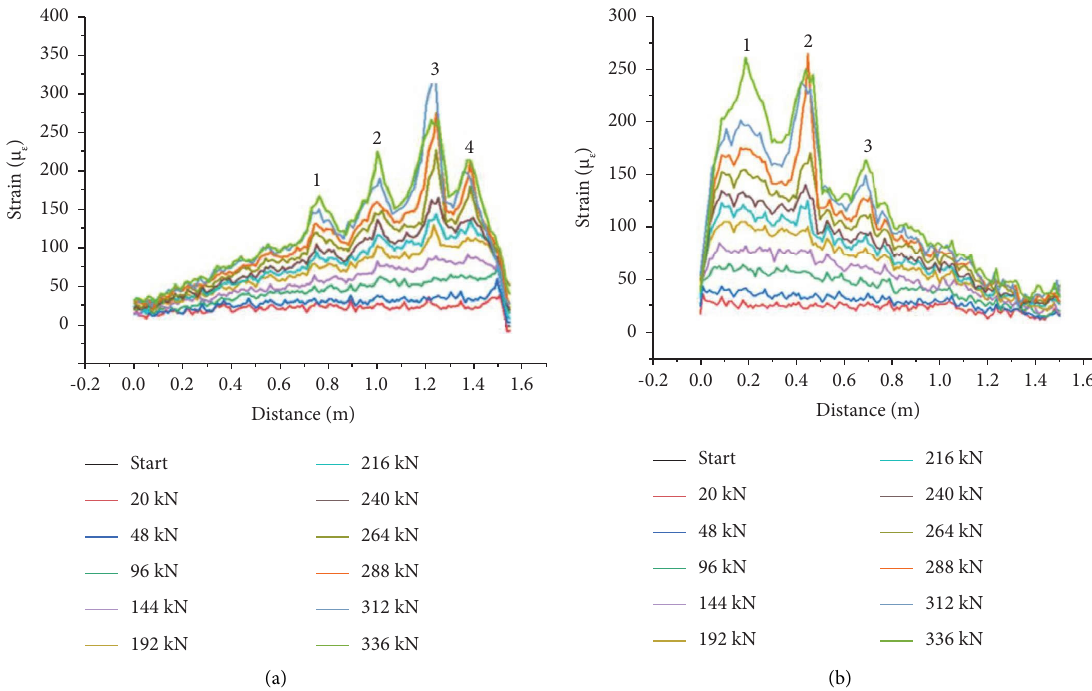
Figure 7: Test diagram of crack distribution law on left and right sides of 5-1. (a) Left side. (b) Right